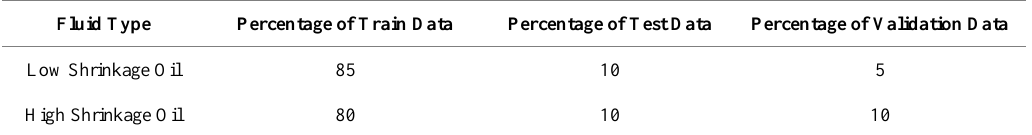
Table 11. Percentage of Data Used in Train, Test and